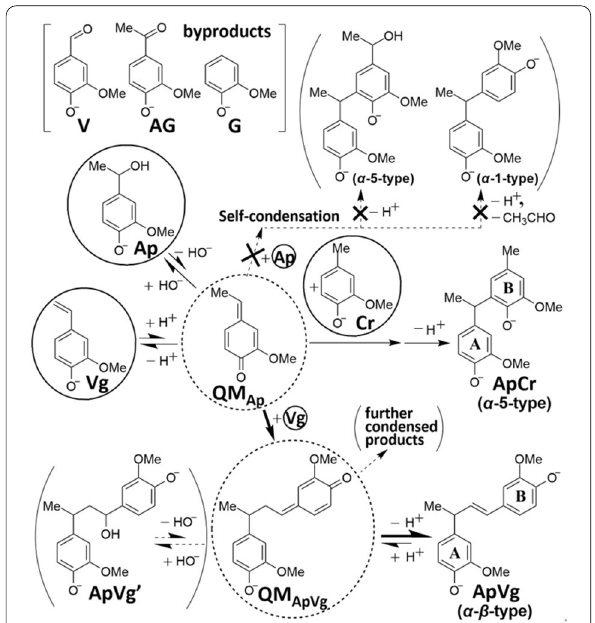
Fig. 4 Summary of the condensation reactions in the soda cooking treatment of Ap and Cr observed in this report. The chemical species enclosed by the solid and dotted circles indicate nucleophiles and electrophiles,